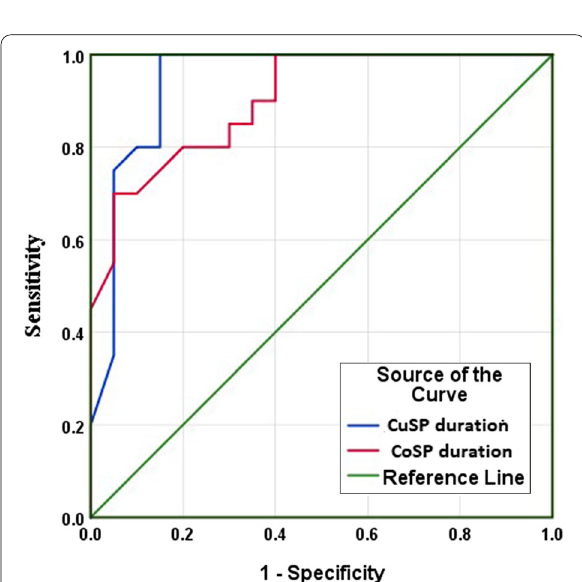
Fig. 2 Receiver operating characteristic curve for CuSP duration and CoSP duration in the context of discrimination between patients and